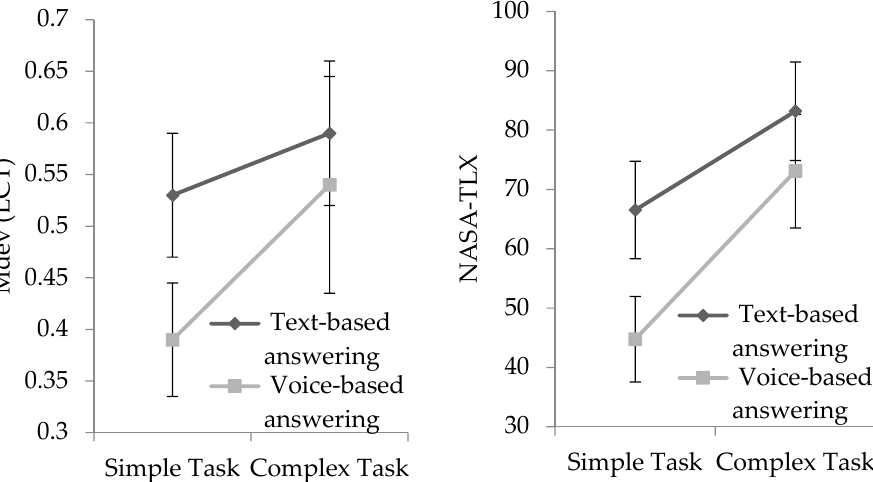
Figure 4. Main and interaction effects of mean deviations in the LCT ( left ) and NASA-TLX scores ( right ) for text- vs. voice-based answering in simple vs. complex tasks.